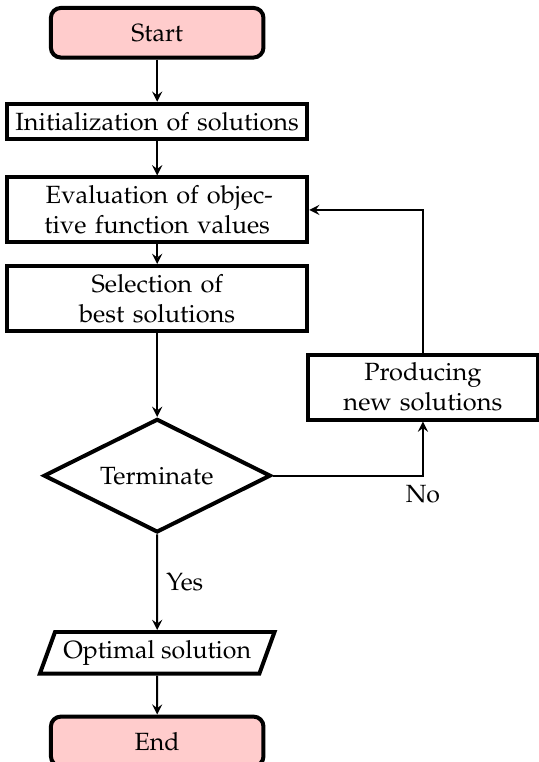
Figure 2. Flowchart of general optimization